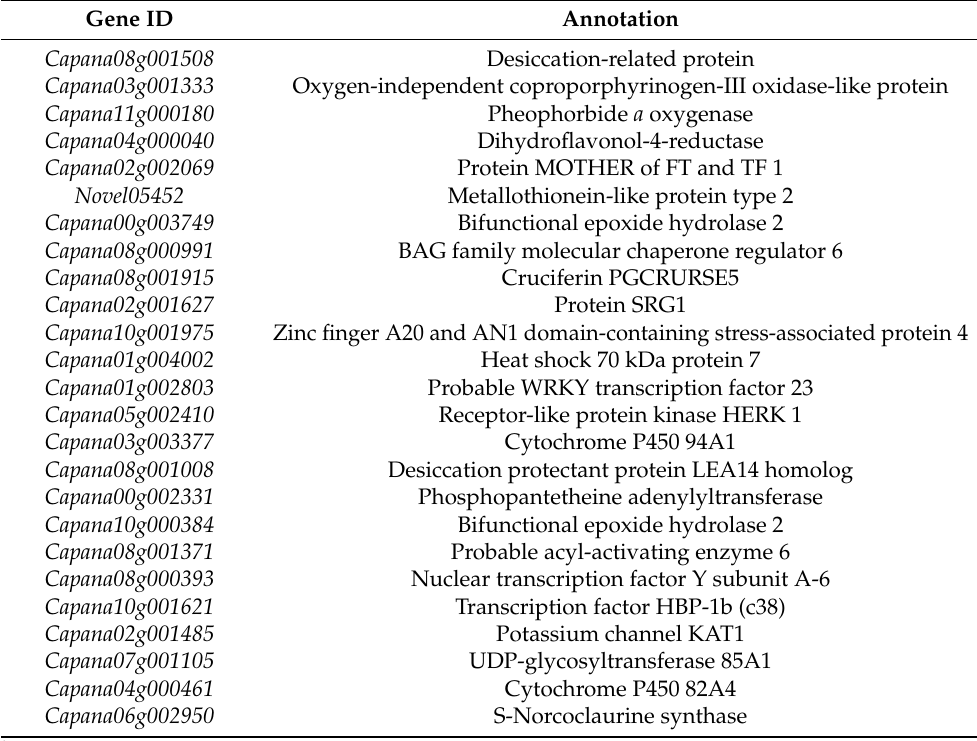
Table 1. Genes highly associated with the β -carotene content in ripening fruits 1 . Gene